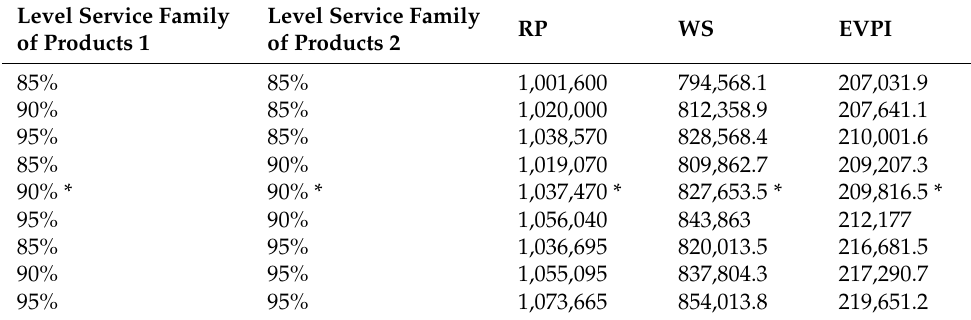
Table 6. Sensitivity analysis developed varying levels of service. * Denotes base